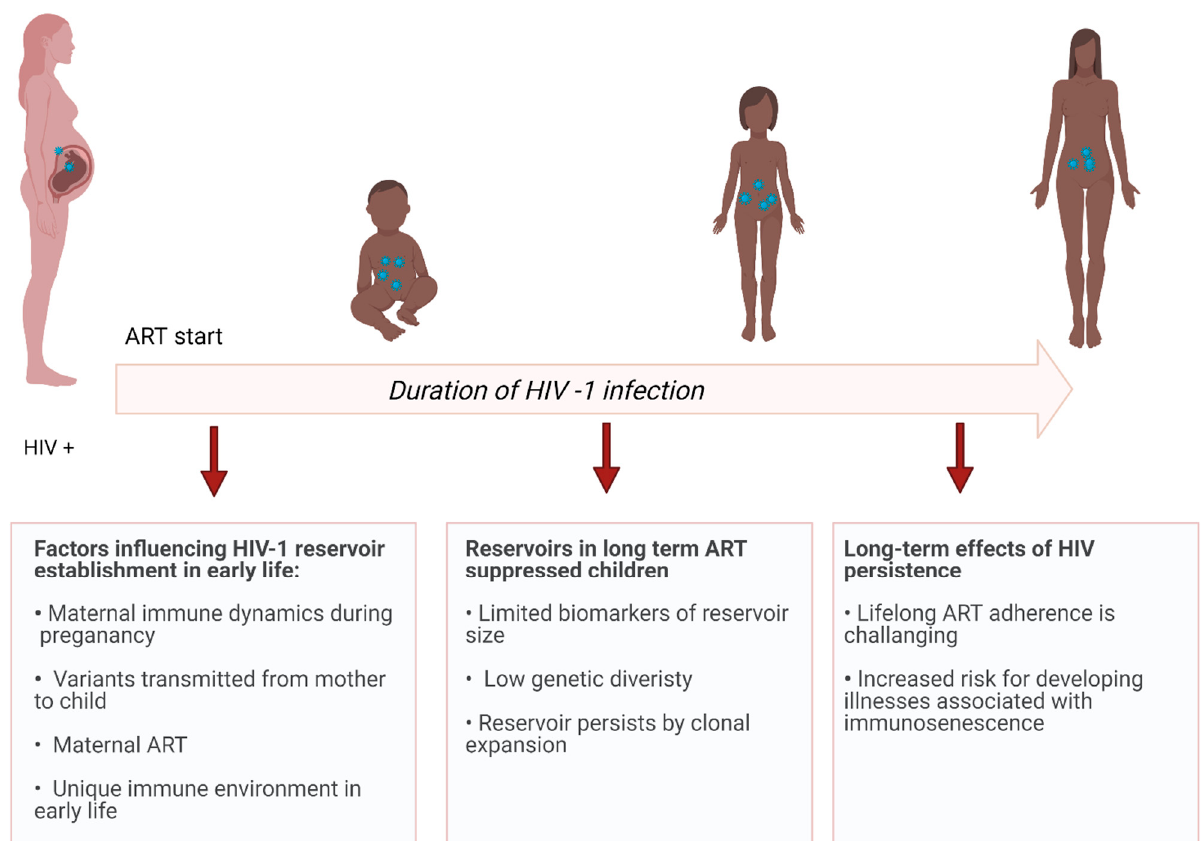
Figure 1. HIV-1 persistence in perinatally infected individuals.